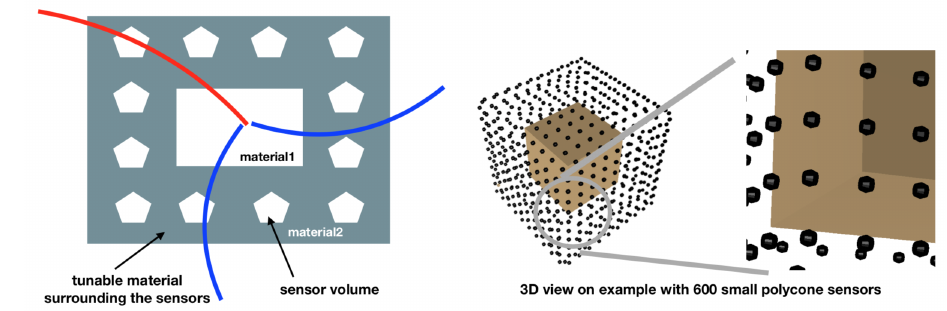
Figure 3. Layout of the geometry test setup (2D cut and 3D view). We use a simple layered geometry with configurable materials as a toy detector. One layer contains a variable number of sensor objects (type configurable). Particle collisions take place at the